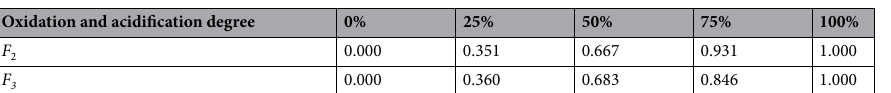
Table 6. Standardized data statistics. F 2 refers to 2 D fractal dimension of crystal contour; F 3 refers to 3 D fractal dimension of gray